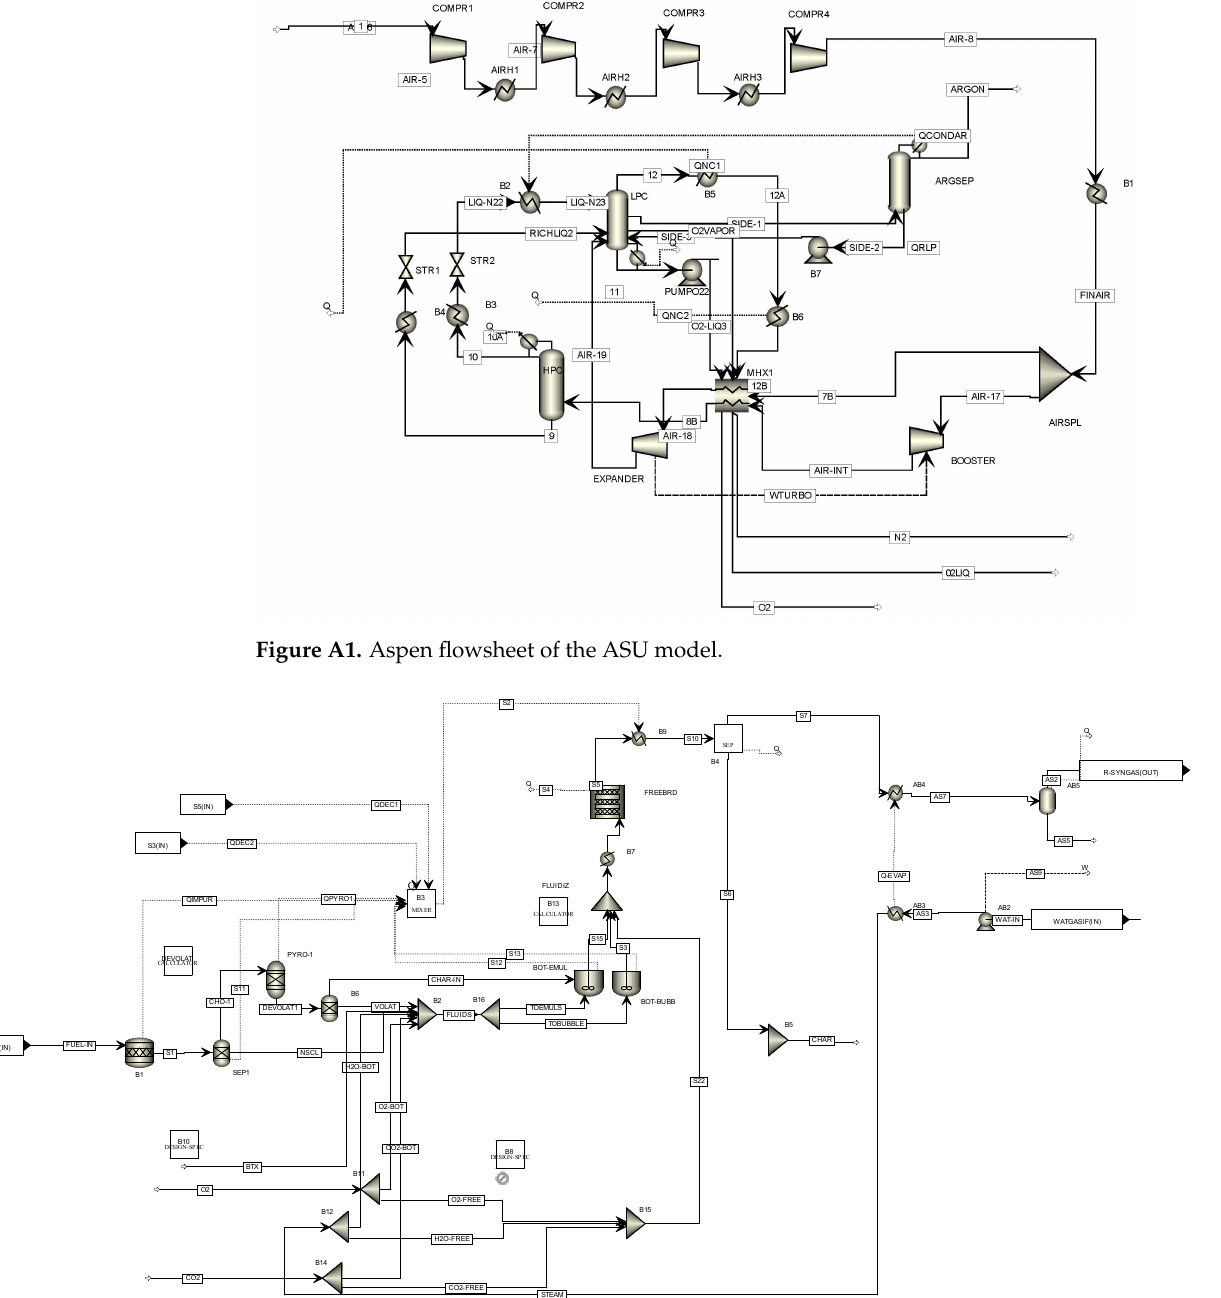
Figure A3. Aspen flowsheet of the gas conditioning model .